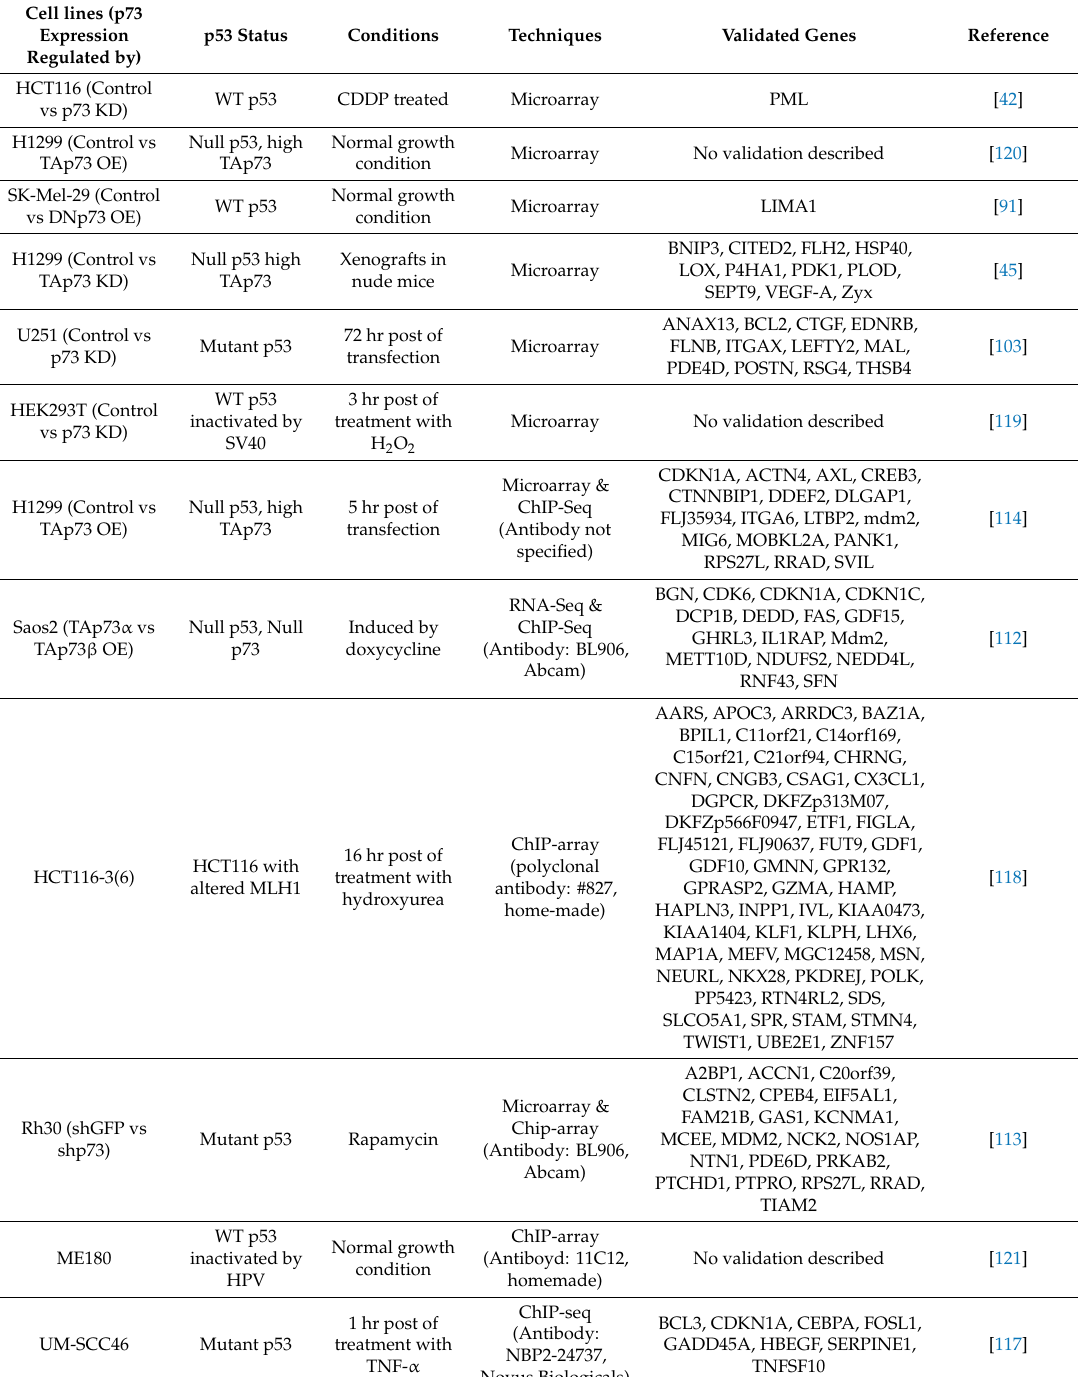
Table 3. Overview of high-throughput studies for the identification of TAp73 target genes. KD: knockdown; OE: overexpression, WT: wild-type; CDDP: